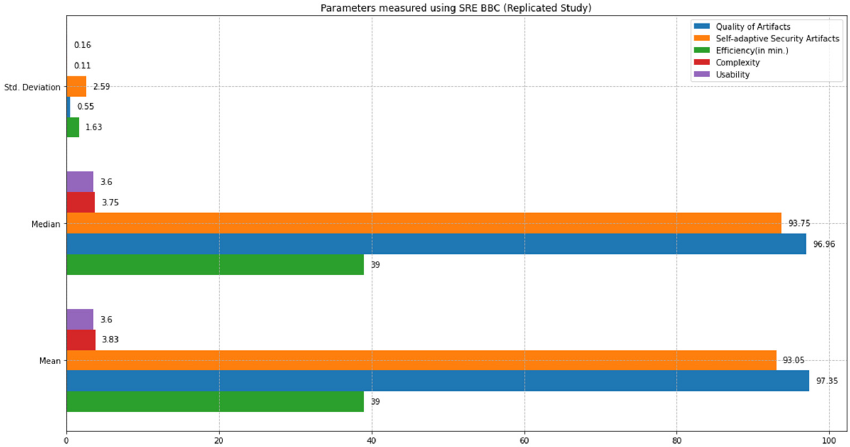
Figure 19. Statistical test for parameters measured using SRE_BBC approach for replicated study. Sensors 2022 , 22 , x FOR PEER REVIEW